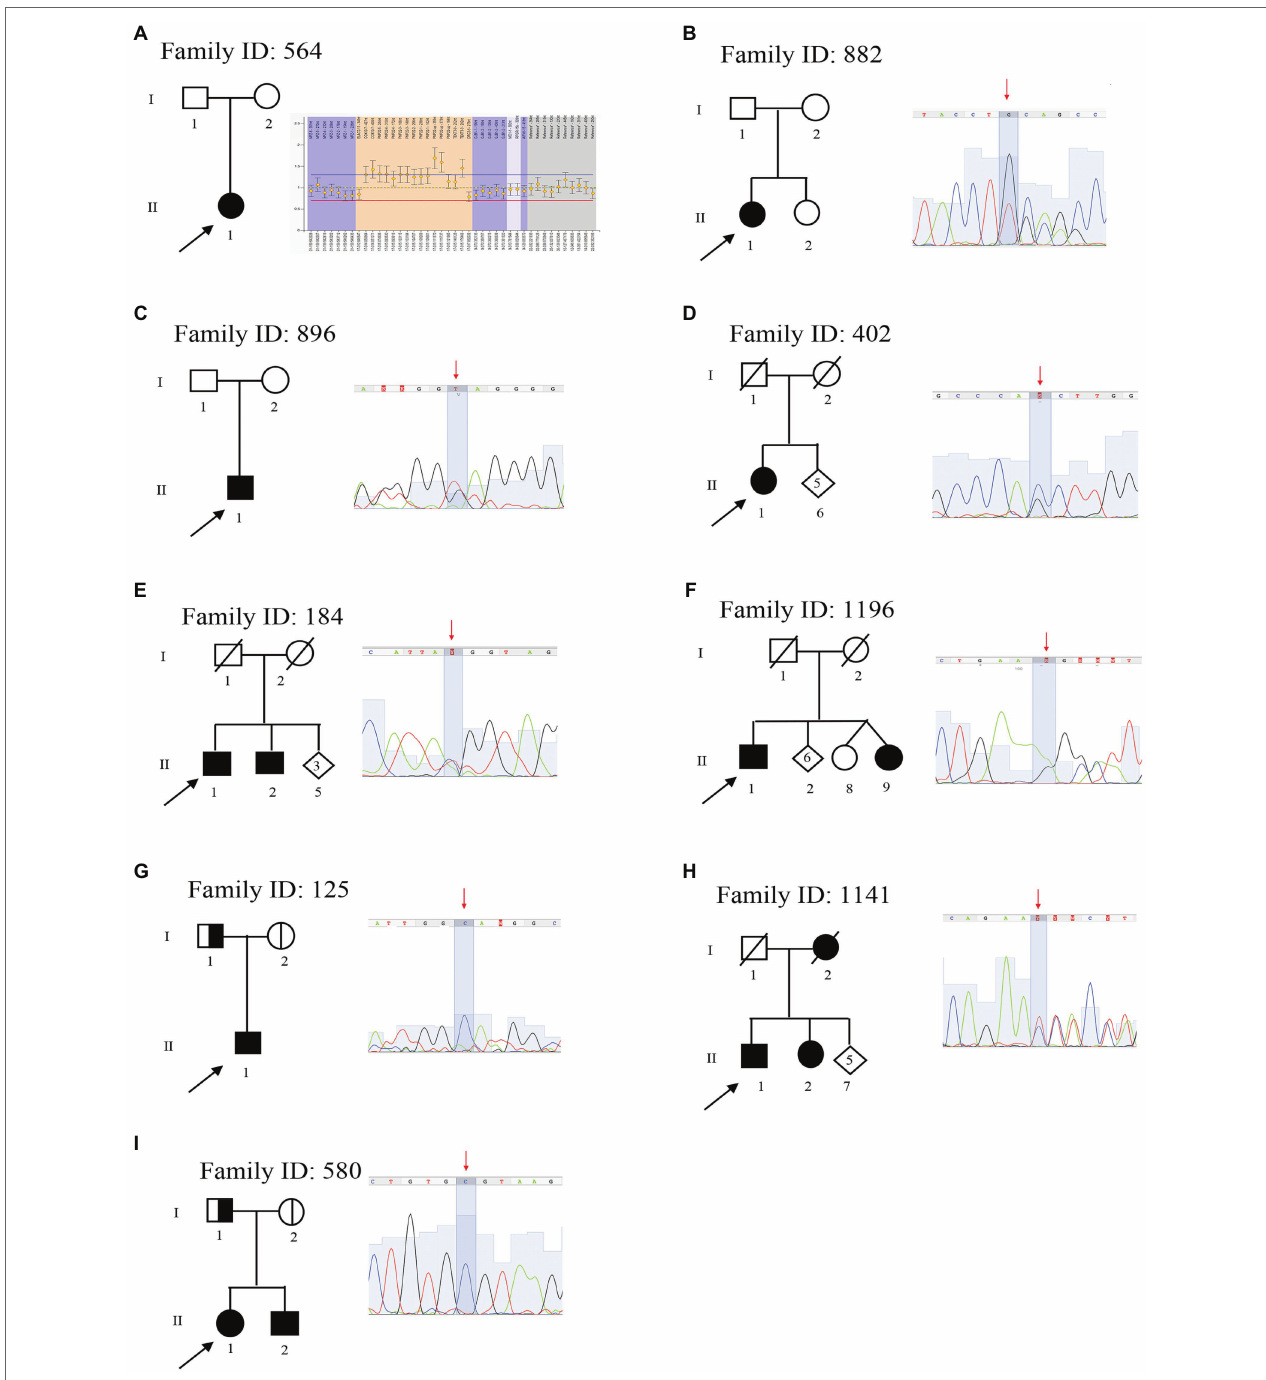
FIGURE 1 | Pedigree and electropherograms of class 4 and 5 mutations identified by next-generation sequencing (NGS). (A) Family ID: 564, MPLA analysis and identified a mosaic duplication of 1.5-Mb (17p11.2–12); (B) Family ID: 882, heterozygous stop mutation in mitofusin-2 ( MFN2 ) gene: NM_001127660.1:c. [2258dupT], NP_001121132.1:p.(Gln754AlafsTer9; rs773371488); (C) Family ID: 896, heterozygous stop mutation in MPZ gene: NM_000530.8: c.[306delA], NP_000521: p.(Asp104ThrfsTer14), (rs281865125); (D) Family ID: 402, heterozygous missense mutation in HSPB1 gene: NM_001540.3:[c.570G > C], NP_001531.1:p.(Gln190His); (E) Family ID: 184, heterozygous missense mutation in KIF1A gene: NM_001244008.2:c.[5332C > T], NP_ p.(Arg1778Trp), (rs765668490); (F) Family ID: 1196, heterozygous stop mutation in GADP1 gene: NM_018972.2: c.[140delA], NP_061845.2: p.(Lys47ArgfsTer3); (G) Family ID: 1251, homozygous splicing mutations in SH3TC2 gene: NM_024577.3: c.[805 + 2T > C], (rs139052887); (H) Family ID: 1141, heterozygous deletion mutation in KIF5A gene: NM_004984.2:c.[2868_2870delTCT], NP_004975.2:p.(Leu957del), (rs575223790); and (I) Family ID: 580, homozygous missense mutation in MTMR2 gene: NM_016156.5:c.[463T > C],